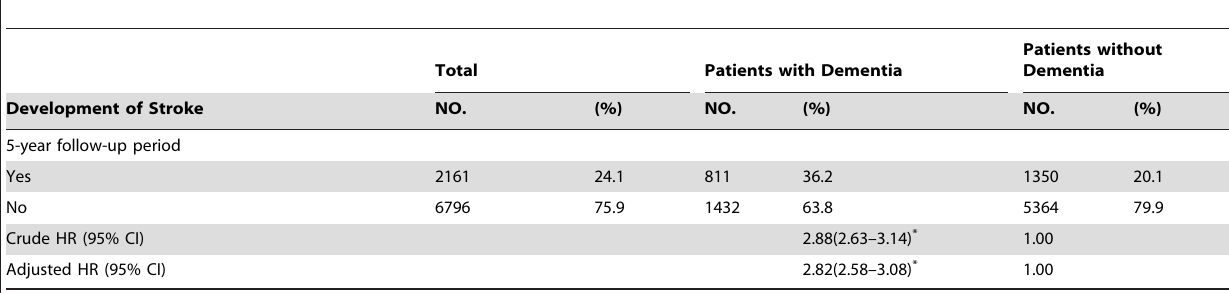
Table 2. Hazard Ratios (HRs) of Stroke among Dementia Patients during the 5-year Follow-up Period from the Index Ambulatory Visits or Inpatient Care.